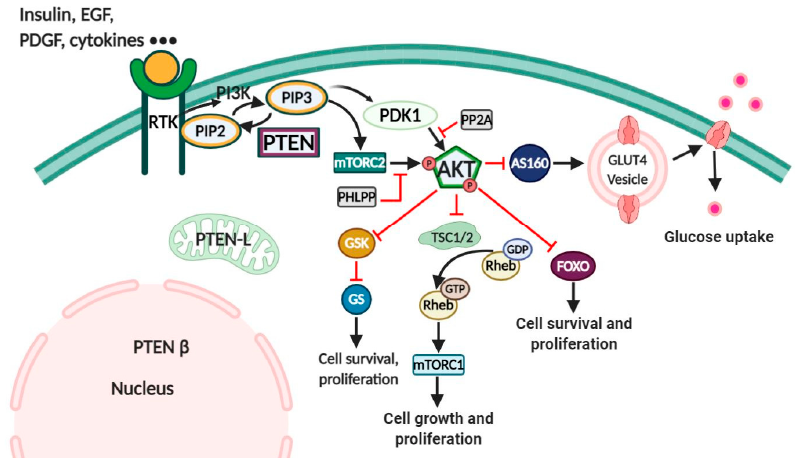
Figure 1. PTEN and PI3K/Akt signaling pathway. Triggering of PI3K by ligands-activated receptors (RTK, GPCR) leads to PIP3 generation. Akt is then activated through phosphorylation by mTORC2 and PDK1, which triggers the downstream signaling through a series of phosphorylation reactions. Activated Akt promotes translation of glucose transporter 4 (GLUT4) through direct inhibition of AS160 (Akt substrate of 160 kDa), which leads to the increase of glucose uptake. Furthermore, through phosphorylation, Akt inactivates forkhead box protein O (FOXO), tuberous sclerosis complex 1/2 (TSC1/2), and glycogen synthase kinase 3 (GSK3), which increases cell survival, cell growth, and proliferation [23]. PTEN dephosphorylates PIP3 to PIP2 and reduces PIP3 accumulation. Black arrows (activating), red arrows